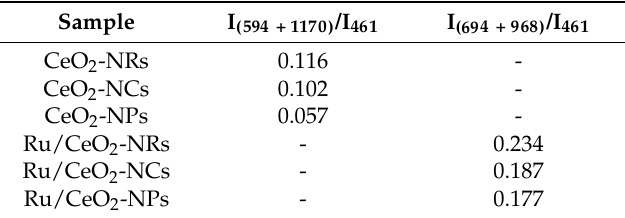
Figure 5. Ru 3d X-ray photoelectron spectroscopy (XPS) spectra of ( a ) Ru/CeO 2 -NRs, ( b ) Ru/CeO 2 -NCs, and ( c ) Ru/CeO 2 -NPs.